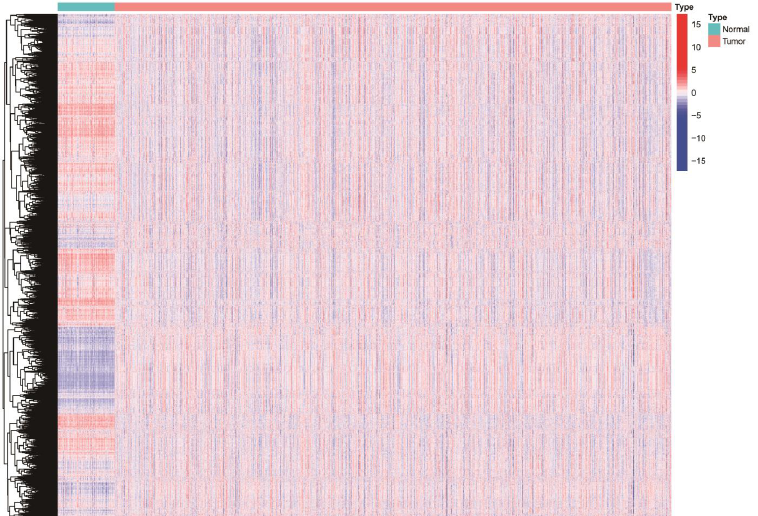
Figure 1. Heatmap of enrichment scores from 4922 immunologic and hallmark gene sets in tumor and non-tumor tissues based on TCGA − BC. N, normal; T, tumor.